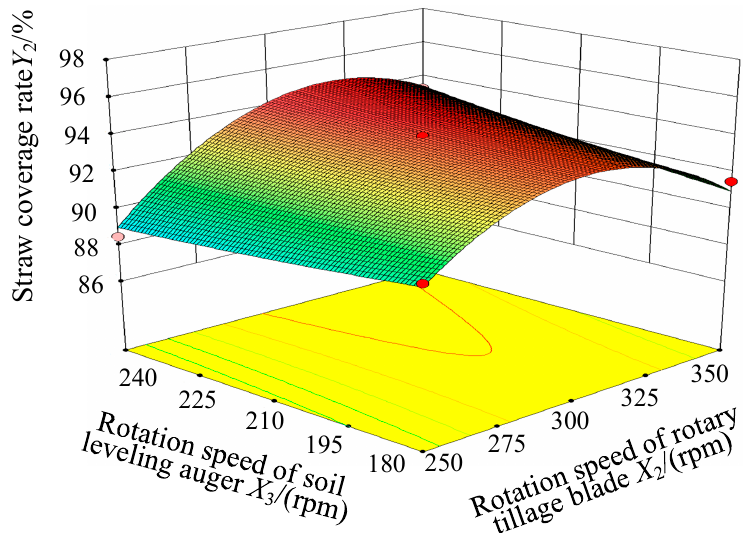
Figure 10. Response surfaces of straw coverage rate to interactive factors X 2 X 3 .